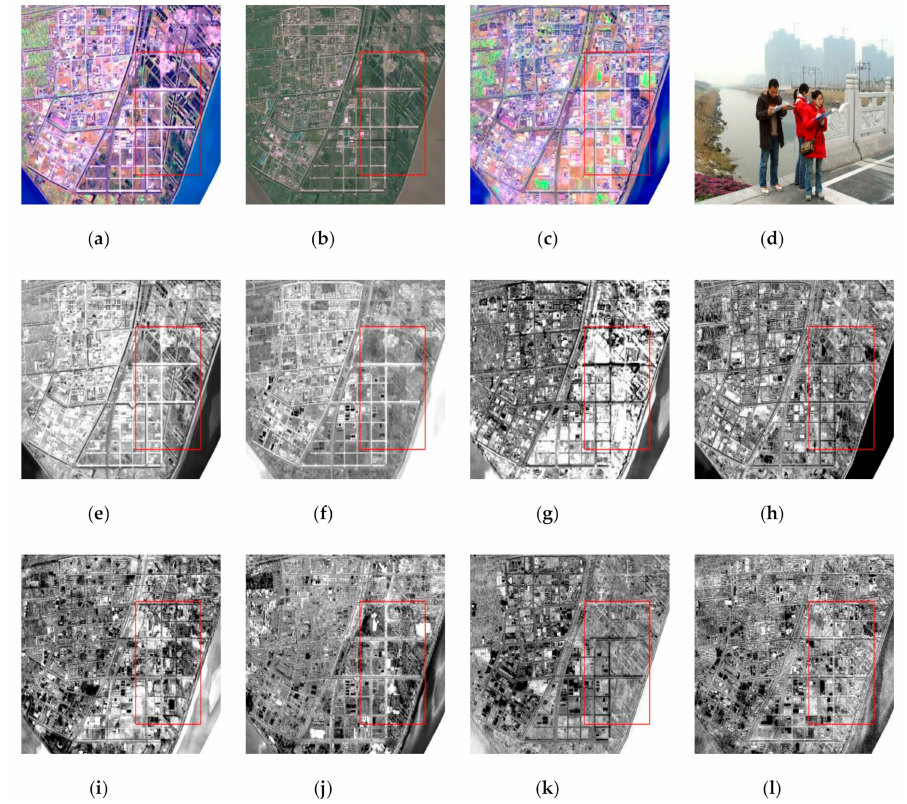
Figure 5. Example of multi-date PCA land use change enhancement, 2003–2006. ( a ) RGB composition image of SPOT-3 (2003); ( b ) color aerial photograph (2000); ( c ) RGB composition image of SPOT-5 (2006); ( d ) field survey photo (2006); ( e – l ) from the first to eighth principal components